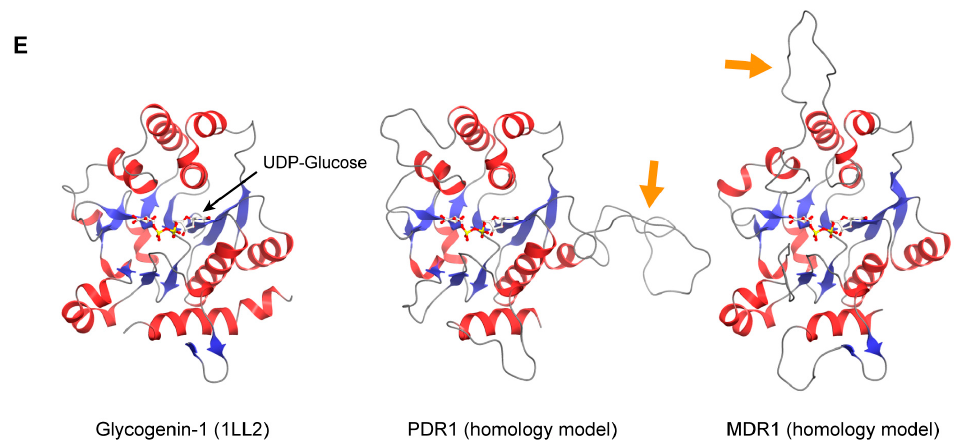
Figure 4. Working models of the glycosyltransferases glycogenin and PDR1. ( A ) Glycogenin is required for the initiation of glycogen biosynthesis, and can be autoglycosylated at a specific tyrosine residue to form a short oligosaccharide chain of glucose molecules to act as a priming chain for the subsequent biosynthesis of glycogen. ( B ) A schematic representation of PD ring filament biosynthesis by PDR1. A series of results suggested that PD ring filaments are composed of both PDR1 and glucose molecules. Considering the sequence similarity with glycogenin, the glycosyltransferase domain of PDR1 may biosynthesize the polyglucan nanofilaments from UDP-glucose residues to form the PD ring filaments. OEM, outer envelope membrane; IMS, intermembrane space. ( C ) Schematic of C. merolae PDR1 and MDR1 domain structures. The glycosyltransferase domains of PDR1 and MDR1 identified them as type-8 subgroup members of the glycosyltransferase family. ( D ) Protein sequence similarities between PDR1, MDR1 and glycogenin-1. ( E ) Comparisons of the protein structure of glycogenin-1 (PDB: 1LL2) and the putative structures of the glycosyltransferase domains of PDR1 and MDR1. Orange arrows indicate specific insertion regions in the glycosyltransferase domains of PDR1 and MDR1. The protein structures of the PDR1 and MDR1 glycosyltransferase domains were modeled as described in Figure 2.